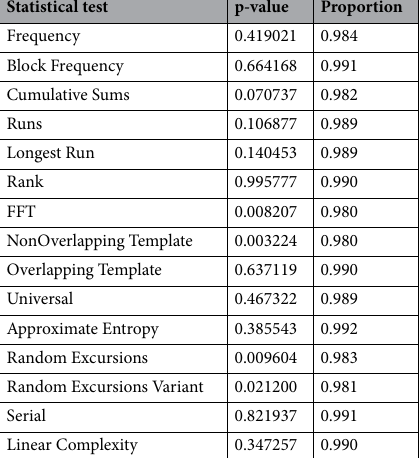
Table 1. Results of the NIST SP 800–22 for the random bit sequence generated at 1.28